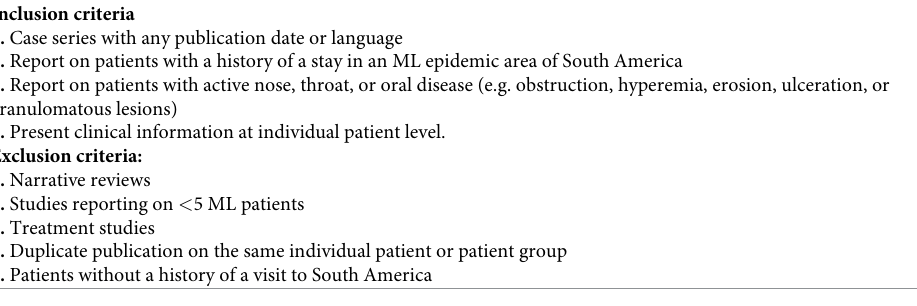
Table 1. General study eligibility criteria for inclusion in this systematic review. Inclusion criteria 1. Case series with any publication date or